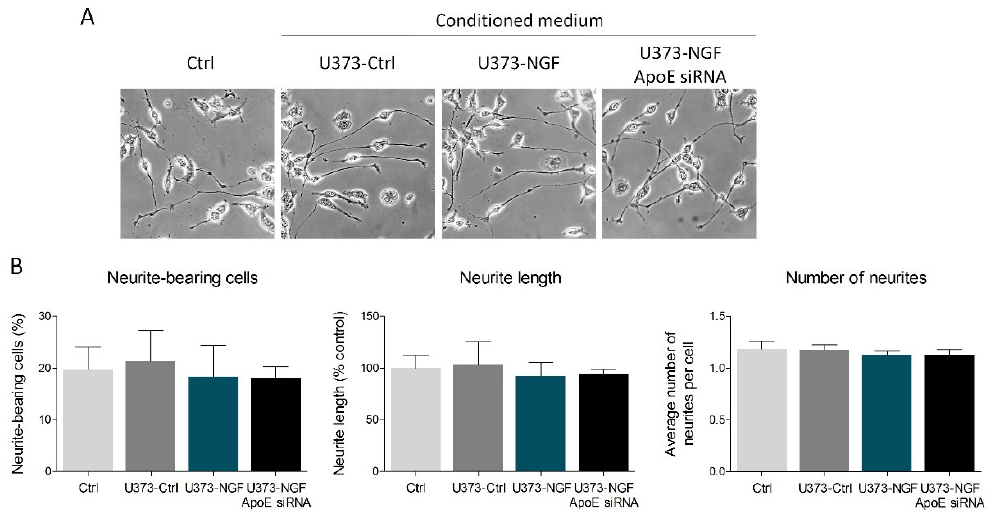
Figure 4. Effect of U373 conditioned medium on neuronal differentiation. ( A ) Representative images in bright field of N1E-115 cells cultured in fresh DMEM (Ctrl), in conditioned medium derived from control U373 (U373-Ctrl), NGF-pre-treated U373 (U373-NGF), and NGF-pre-treated U373 silenced for ApoE (U373-NGF ApoE siRNA) for 48 h. ( B ) Morphological analysis of neurite-bearing cells, neurite length and number of neurites of N1E-115 cells in the presence of fresh DMEM (Ctrl), in conditioned medium derived from control U373 (U373-Ctrl), NGF-pre-treated U373 (U373-NGF), and NGF-pre-treated U373 silenced for ApoE (U373-NGF ApoE siRNA) for 48 h. n = 5 different experiments. Data represent means ± SD. Statistical analysis was performed by using one-way ANOVA, followed by Tukey’s post hoc test.